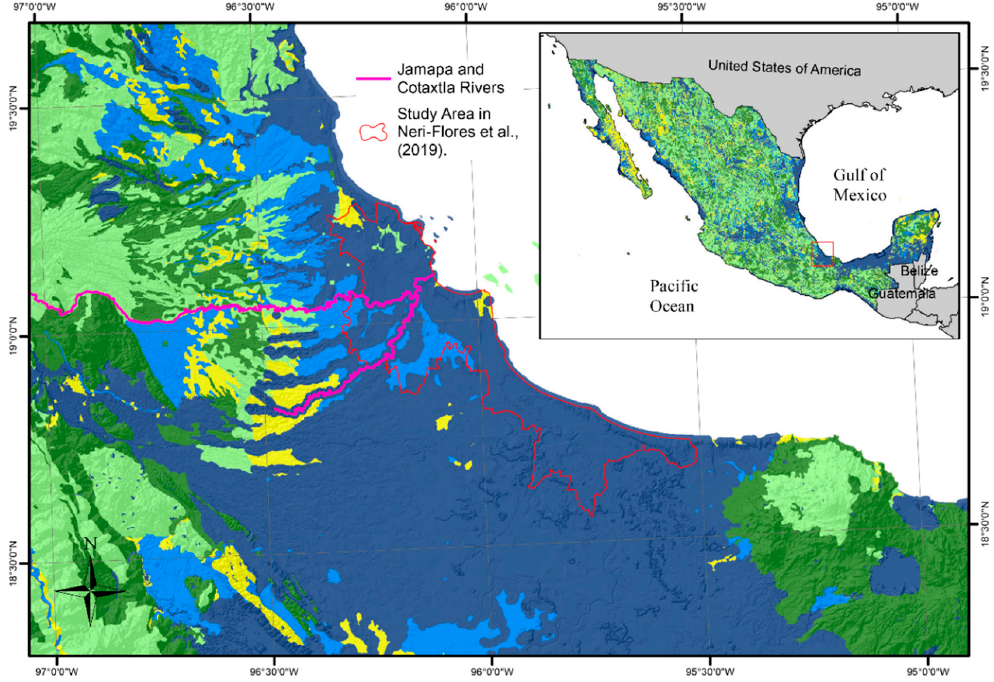
Figure 8. Detail of superficial evidence of the presence of groundwater flow systems highlighting the area studied in [72].